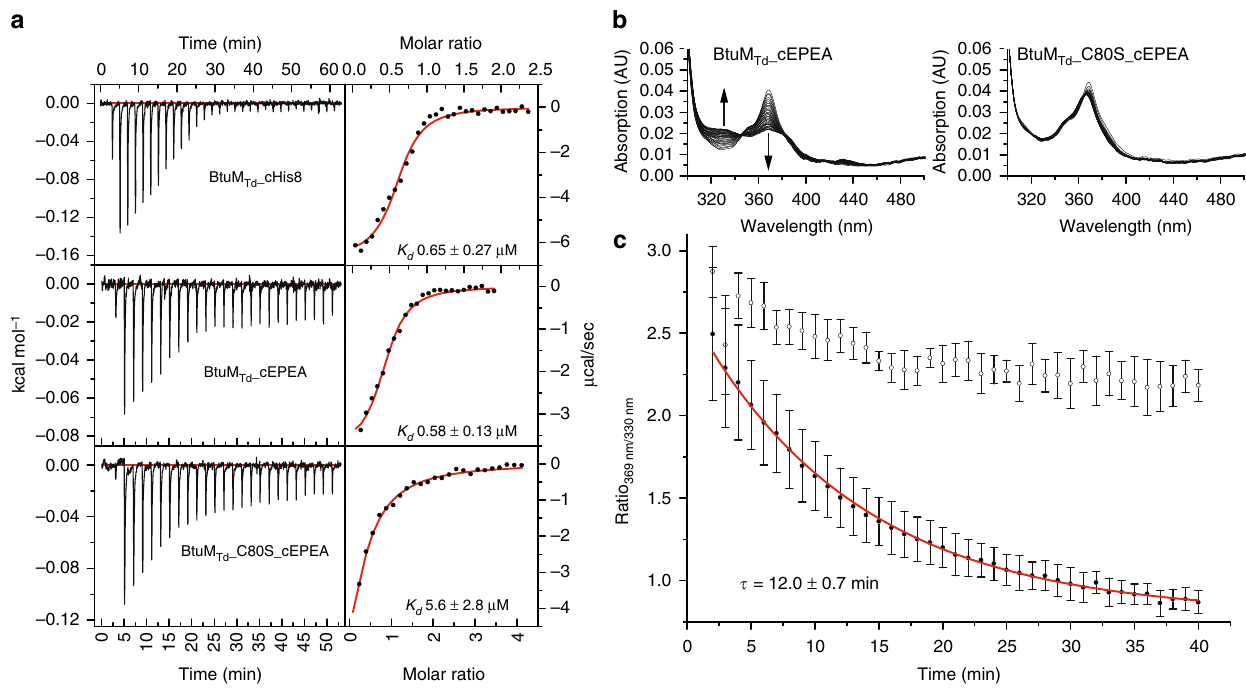
Fig. 3 Cobinamide (Cbi) binding to BtuM Td and BtuM Td -catalysed decyanation. a Representative ITC-measurements of differently tagged BtuM Td constructs. BtuM Td with a C-terminal His-tag binds Cbi with a K d value of 0.65 ± 0.27 μ M (top). EPEA-tagged BtuM Td binds Cbi with essentially the same af fi nity of K d 0.58± 0.13 μ M (middle). For the EPEA-tagged mutant version BtuM Td _C80S K d = 5.6 ± 2.8 μ M (bottom). All ITC experiments were performed as technical triplicates, error is s.d. b Decyanation of Cbi catalysed by EPEA-tagged BtuM Td . Upon addition of an excess of BtuM Td to Cbi, the substrate is slowly decyanated, which can be followed spectroscopically (left) with the main spectral changes indicated by the arrows. The mutant BtuM Td _C80S, did not catalyse decyanation (right). c Quanti fi cation (error bars are s.d. of technical triplicates) of decyanation reveals that the process